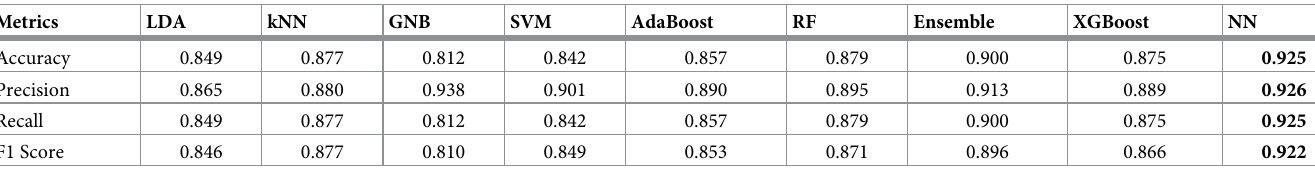
and integrated the selected handcrafted, radiomic, and deep features, as demonstrated in Tables 7 and 8, respectively. To efficiently compare our proposed approach with the reference COVID-19 baseline, we selected seven studies working on the three-class (HC, pneumonia, and COVID-19) classifica- tion task. Table 9 shows the dataset, deep learning architecture, preprocessing steps, and classi- fication results of each study. For the classification tasks using Chest X-ray images, deep learning-based models are commonly required a bunch of data (i.e. public ChestX-ray14 data- set with more than 100,000 images). However, regarding the current COVID situation, the public dataset is very limited. For example, PDCOVIDNet [74] was introduced to detect COVID-19 from chest X-ray images by a dilated CNN. Their dataset included only 219